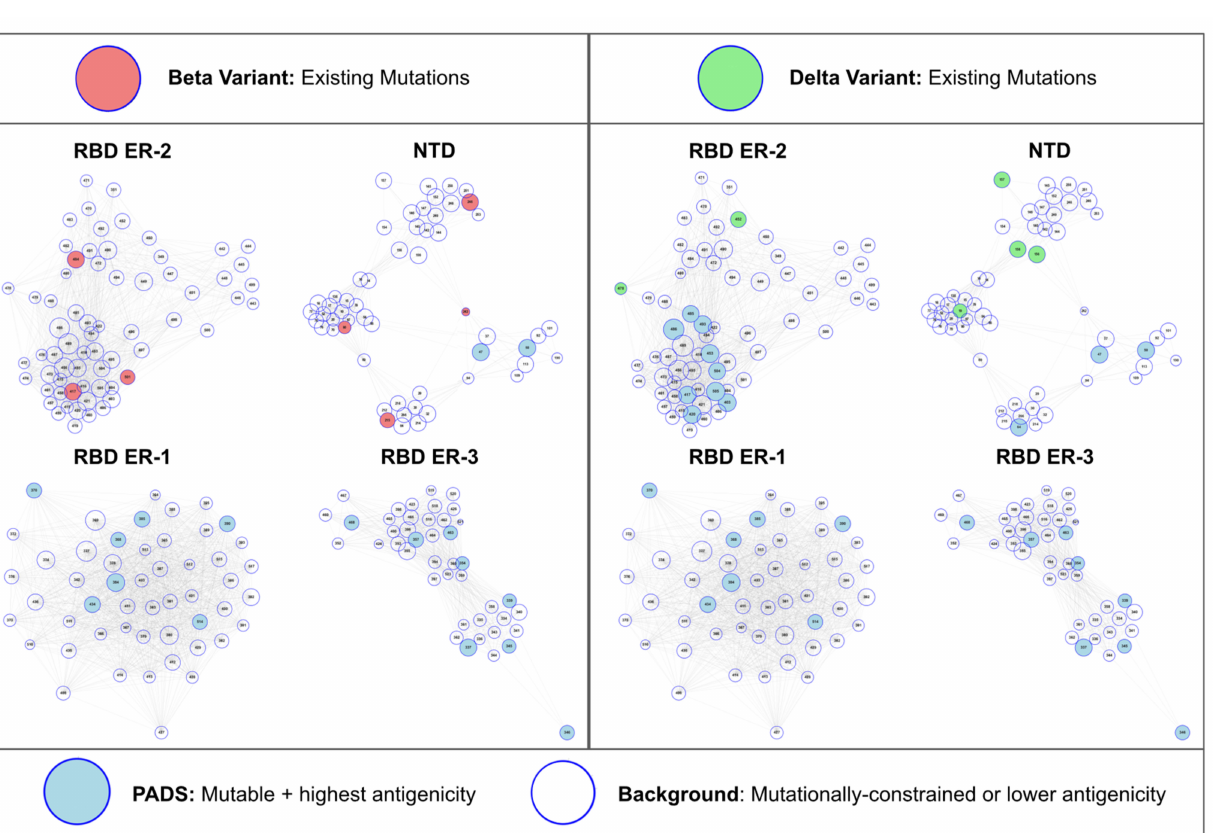
Figure 4. Beta and Delta Variants in RBD + NTD Antigenic Space. Current Beta and Delta variant mutations are illustrated in antigenic space as red or green highlights, respectively. In regions of antigenic space that are not currently mutated for these variants, we annotate the highest mutability and antigenicity sites (PADS) in these unmutated regions as sites of potential complementary antibody evasion upon mutation. That is, mutations in these regions are most likely to knockdown orthogonal components of the antibody response directed against RBD and NTD alongside existing Beta and Delta variant mutations. Specifically, the Delta variant lacks mutations in the RBD ER-2B, NTD DH1052, and NTD outlier clusters. The Beta variant mutations have largely covered all ER-2 and NTD clusters. Neither variant currently features mutations in RBD ER-1 or RBD ER-3, suggesting escape complementarity for mutations in these regions (Figure